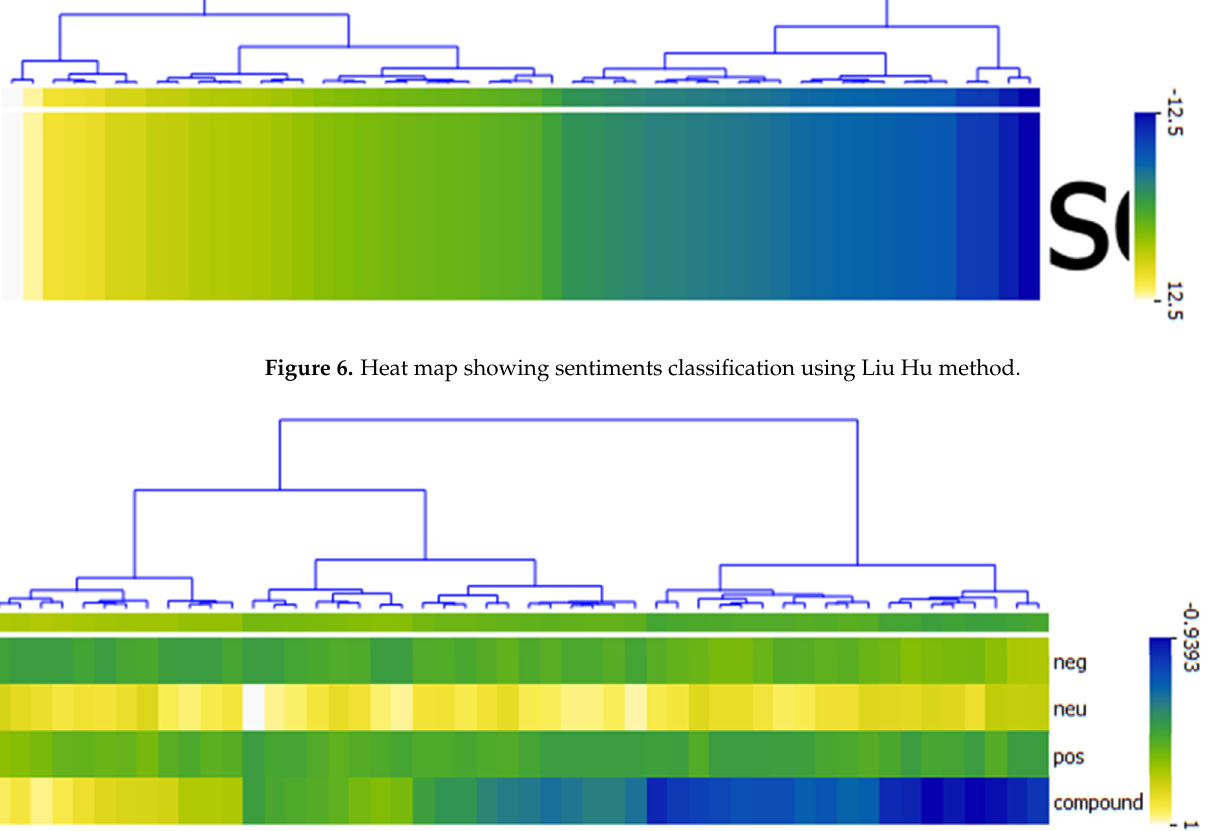
sider each of the subplots as having four quadrants, which are: true negatives (lower left), true positives (upper right), false negatives (upper left), and false positives (lower right) representing the accuracy of the tweet’s sentiment classification. The more the data point in the false negatives and false positives quadrants implies decrease in the sentiment classification accuracy.